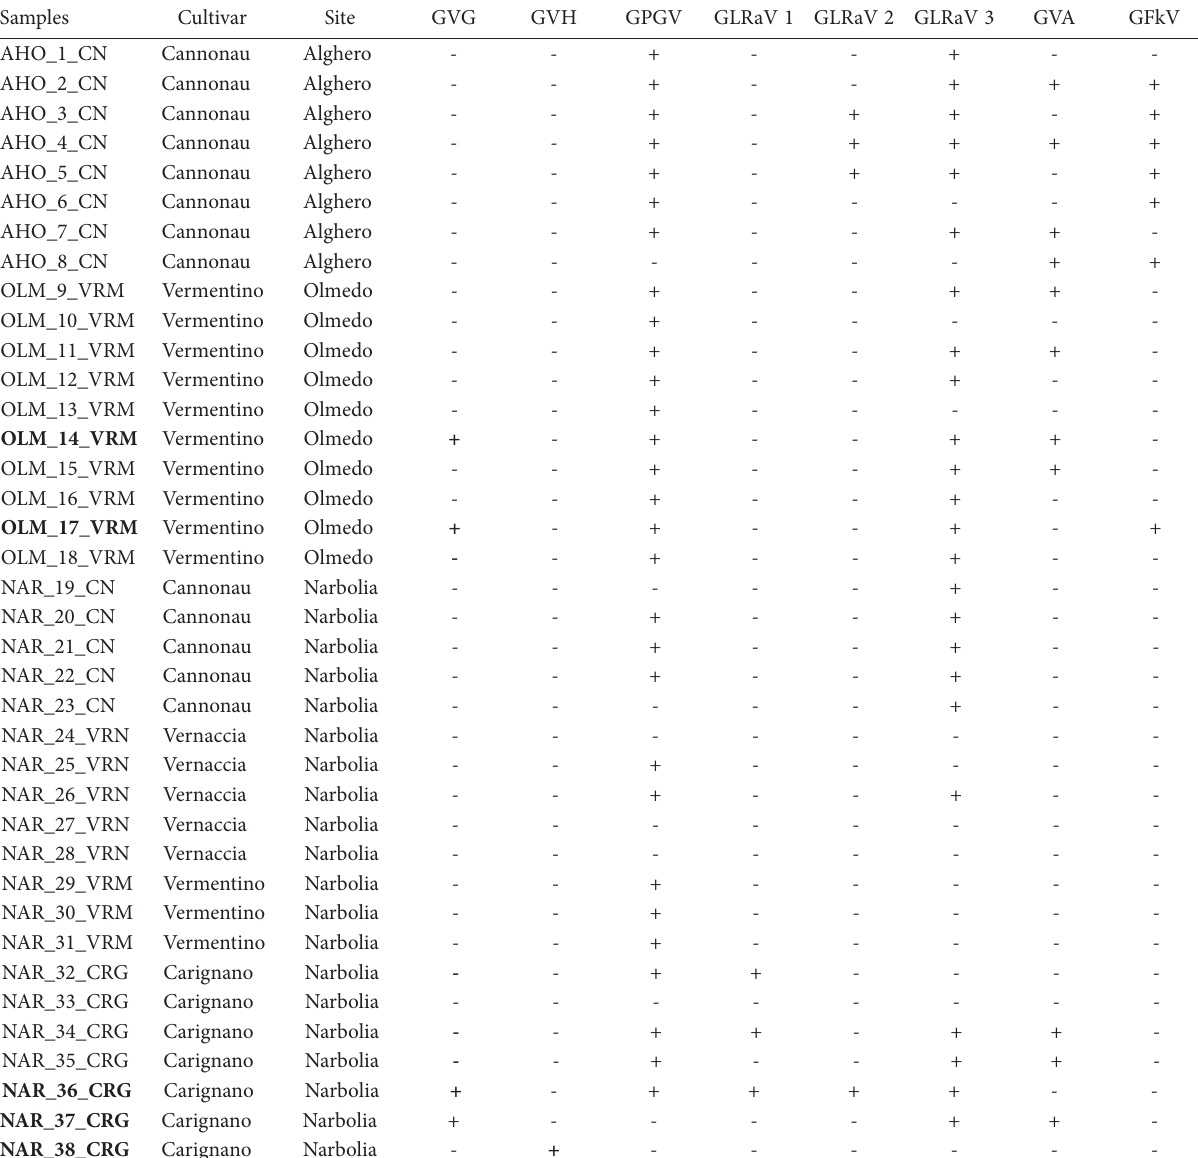
Table 1. RT-PCR detection of different viruses in different grapevine in Sardinia, in cvs. ‘Cannonau’(CN) located in Alghero (AHO) and Narbolia (NAR), ‘Vermentino’ located in Olmedo (OLM) and Narbolia (NAR), and ‘Vernaccia’ (VRN) and ‘Carignano’ (CRG) located in Narbolia (NAR). Vines positives for GVG and GVH are indicated in bold